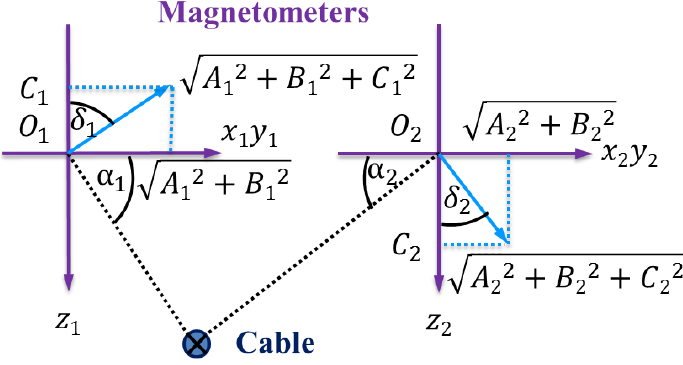
Figure 4. Assume that the cable is located in the middle of two tri-axial magnetometers; there is C 1 < 0 and C 2 > 0. Hence, tan ( δ 1 )